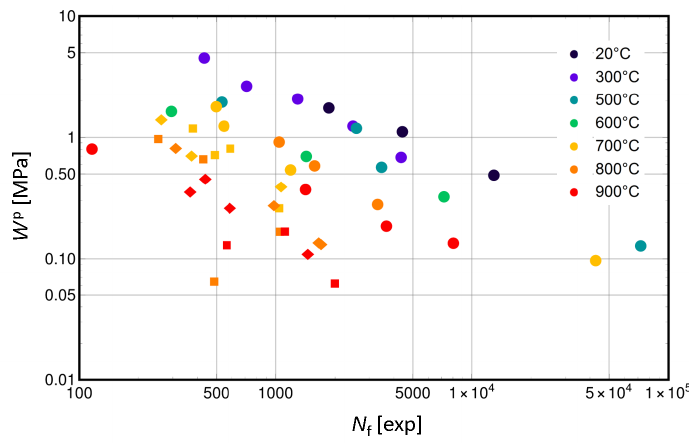
Figure 2. Plastic strain energy density computed as the area inside the closed cyclic loop at the half lifetime (see Figure 1a,b) versus number of cycles to failure. The filled circles ( u ) represent LCF tests, the squares ( p ) represent non-isothermal IP tests and the diamonds ( f ) show non-isothermal OP tests. The highest temperature of the TMF tests is indicated by the